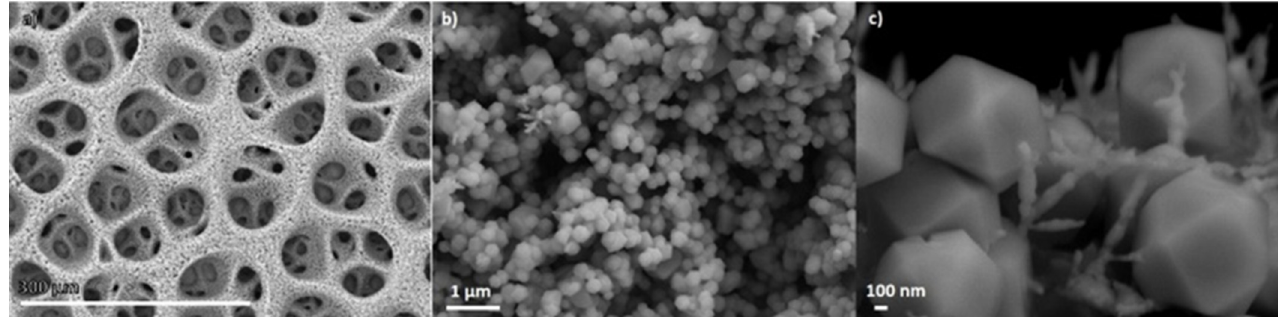
Figure 1. SEM images of CF-18H at various magnifications. ( a ) ×300, ( b ) ×15,000 and ( c ) ×35,000 magnifications. These images are taken of the top portion of the foam.